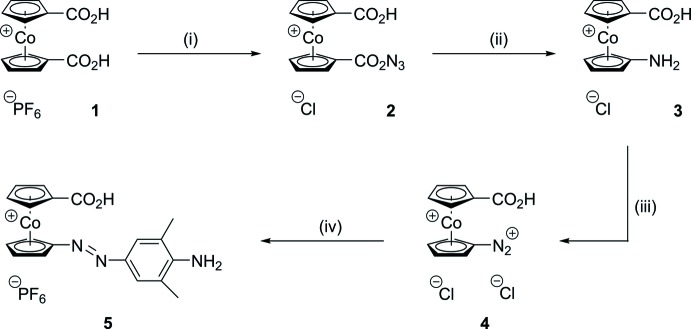
Synthetic scheme for obtaining the title compounds. (i) SOCl2/NaN3, (ii) H2SO4, (iii) HCl/NaNO2, (iv) 2,6-di­methyl­aniline.